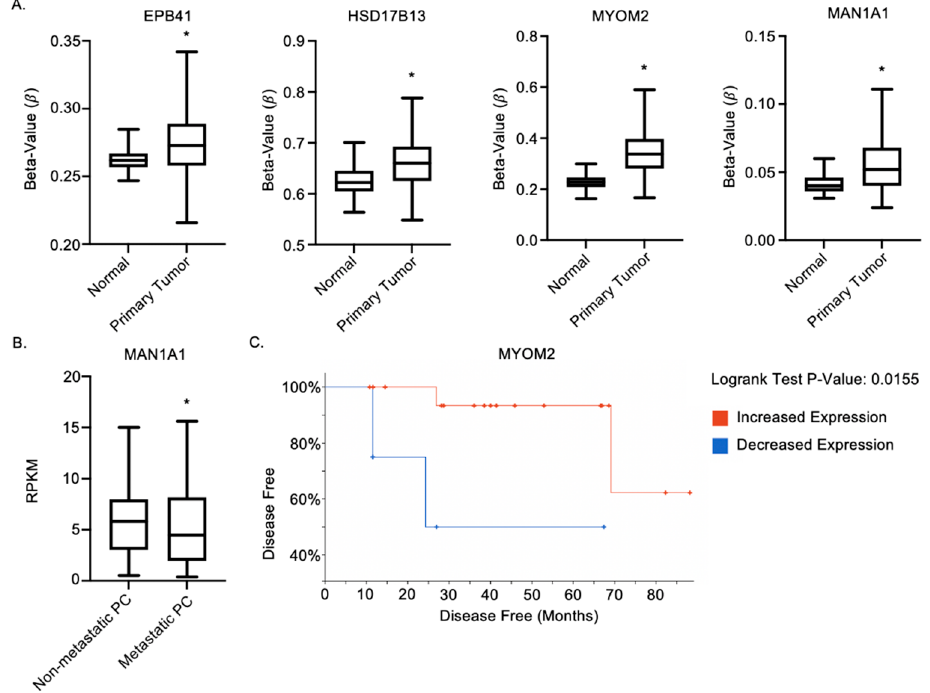
Figure 7. MAN1A1 , EPB41 , HSD17B13 and MYOM2 are altered in prostate cancer patients. ( A , B ) Ualcan analysis in prostate adenocarcinoma identified ( A ) 4 target genes ( MAN1A1 , EPB41 , HSD17B13 and MYOM2 ) with increased promoter methylation in primary prostate cancer tumors (n = 502) compared to normal prostatic samples (n = 50) and ( B ) MAN1A1 RNA expression in metastatic prostate cancer (PC) (n = 42) vs. non-metastatic prostate cancer (n = 44). ( C ) cBioportal analysis of relationship between MYOM2 expression and progression free survival. * = significantly different between conditions.